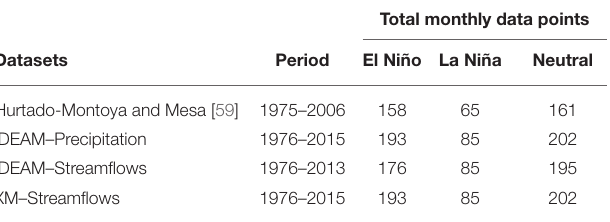
TABLE 1 | Sample size of monthly anomalies according to the phases of ENSO for each